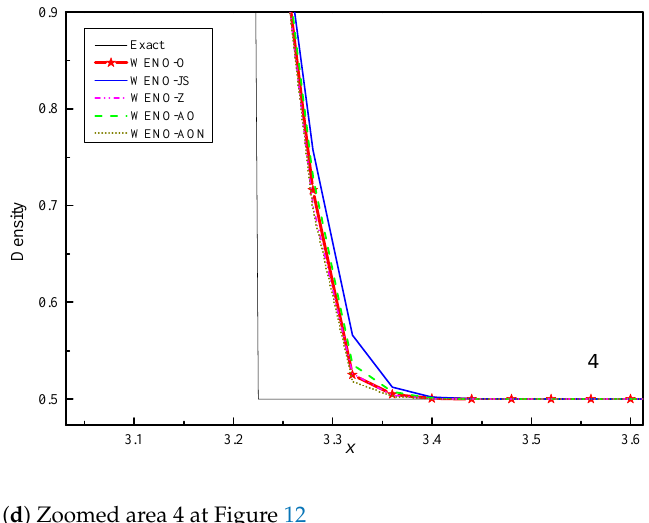
( d ) Zoomed area 4 at Figure 12 Figure 13. Zoomed regions of numerical results of Lax’s problem of Example 4 (Figure 12) (Section 6.2.1) for density field at time t = 1.3, CFL = 0.95 with 200 cells for the considered WENO schemes.